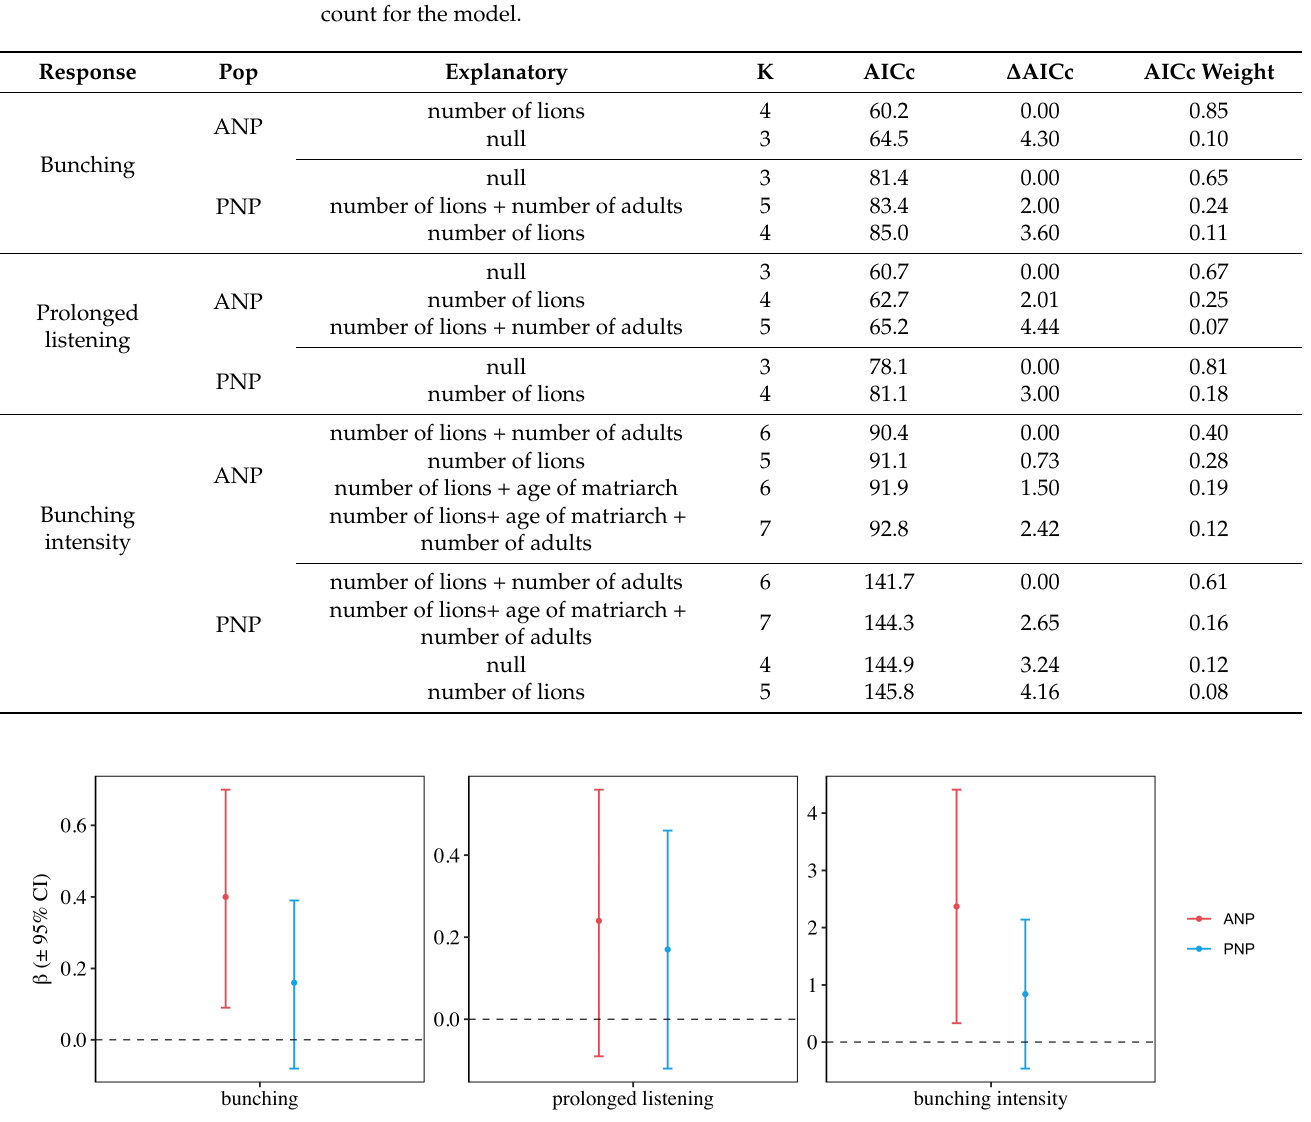
Figure 1. Model averaged β -estimates ( ± 95%) of the number of lions parameter for Amboseli National Park (ANP) and Pilanesberg National Park (PNP). β -estimates were generated from the 6 model sets for each study population and were considered significant when the 95% CI did not overlap zero (dashed horizontal